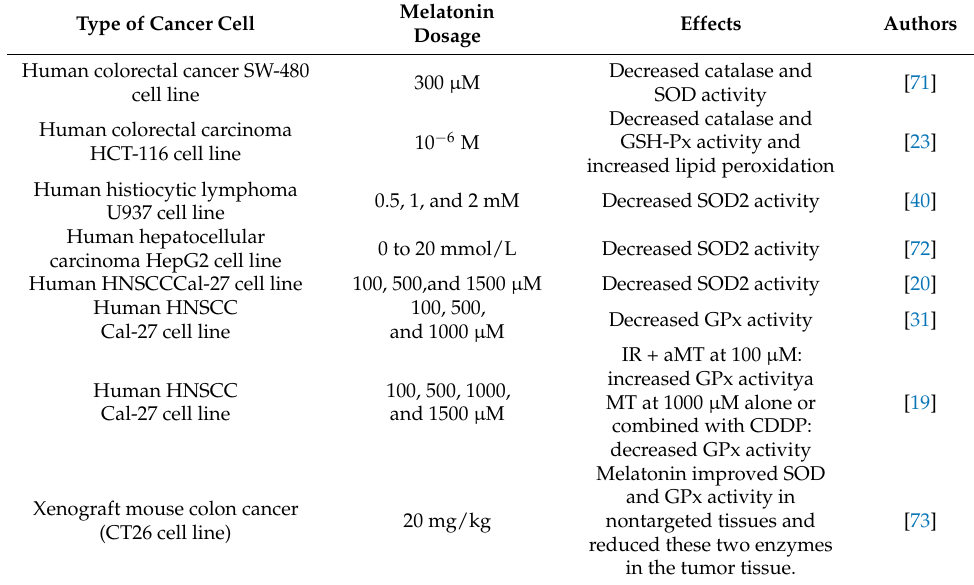
Table 1. Studies of melatonin’s effects on antioxidant defenses in cancer